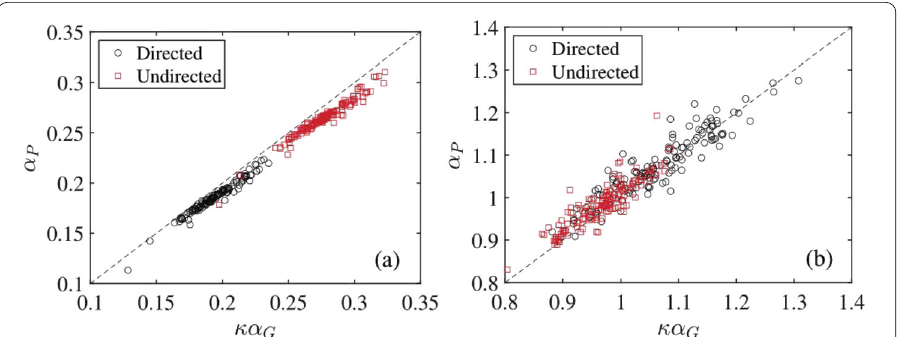
Figure 11 Testing the relationship α G κ = α P . The data for the dates during 1 February 2019 to 9 February 2019 are excluded. ( a ) Exponents α G are those in Fig. 3(a) for the directed networks and Fig. 3(c) for the undirected networks, while exponents α P are those in Fig. 6(a) for the directed networks and Fig. 6(c) for the undirected networks. ( b ) Exponents α G are those in Fig. 3(b) for the directed networks and Fig. 3(d) for the undirected networks, while exponents α P are those in Fig. 6(b) for the directed networks and Fig. 6(d) for the undirected networks